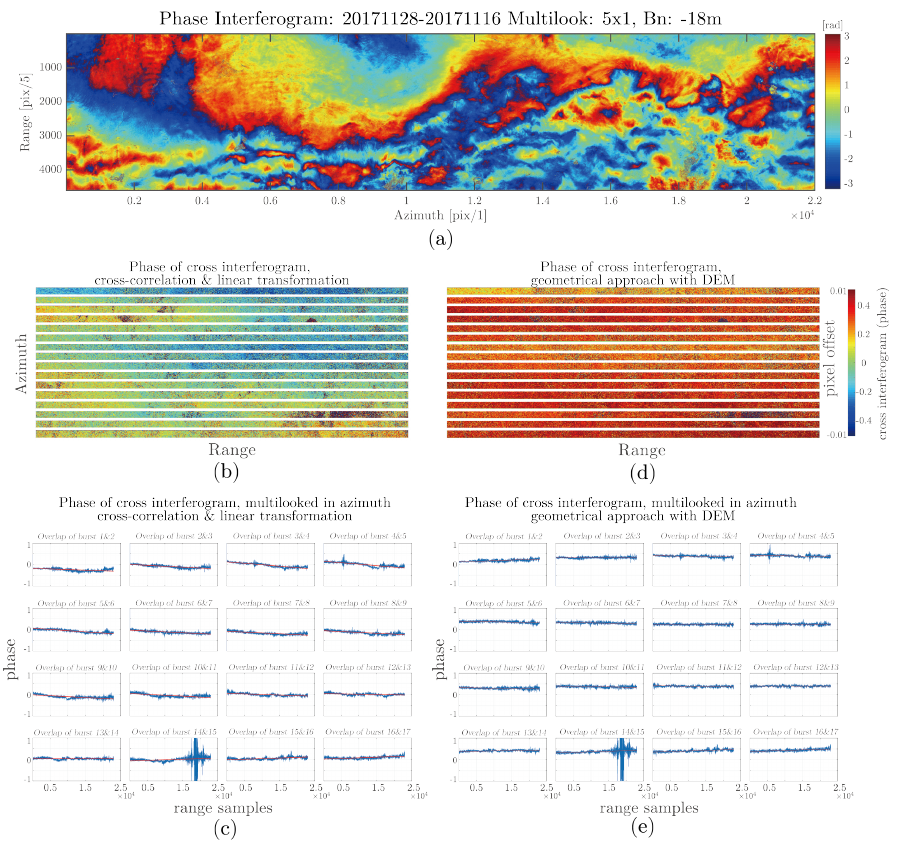
Figure 2. Interferogram of two S1A images on 16 November 2017 and 28 November 2017 from subswath 2. This test site is located in the Atacama Desert. For each date, 17 bursts are stitched together. ( a ) the interferogram, multilooked by 5 in range, no multilooking in azimuth, no filter is used; ( b ) the cross-interferogram at only the burst overlapping area between two consecutive bursts, after the cross-correlation method. The color bar is from − 0.5 to 0.5 radians, corresponds approximately from − 0.01 to 0.01 pixel miscoregistration; ( c ) the cross-interferogram at the 16 burst overlapping areas in the 1D plot. The azimuth dimension is multilooked (summed) to get the 1D plot. The x-axis is range and y-axis is the cross-interferogram phase; ( d ) the cross-interferogram after the geometrical approach; ( e ) the 1D plot of cross-interferogram at 16 burst overlapping areas after the geometrical